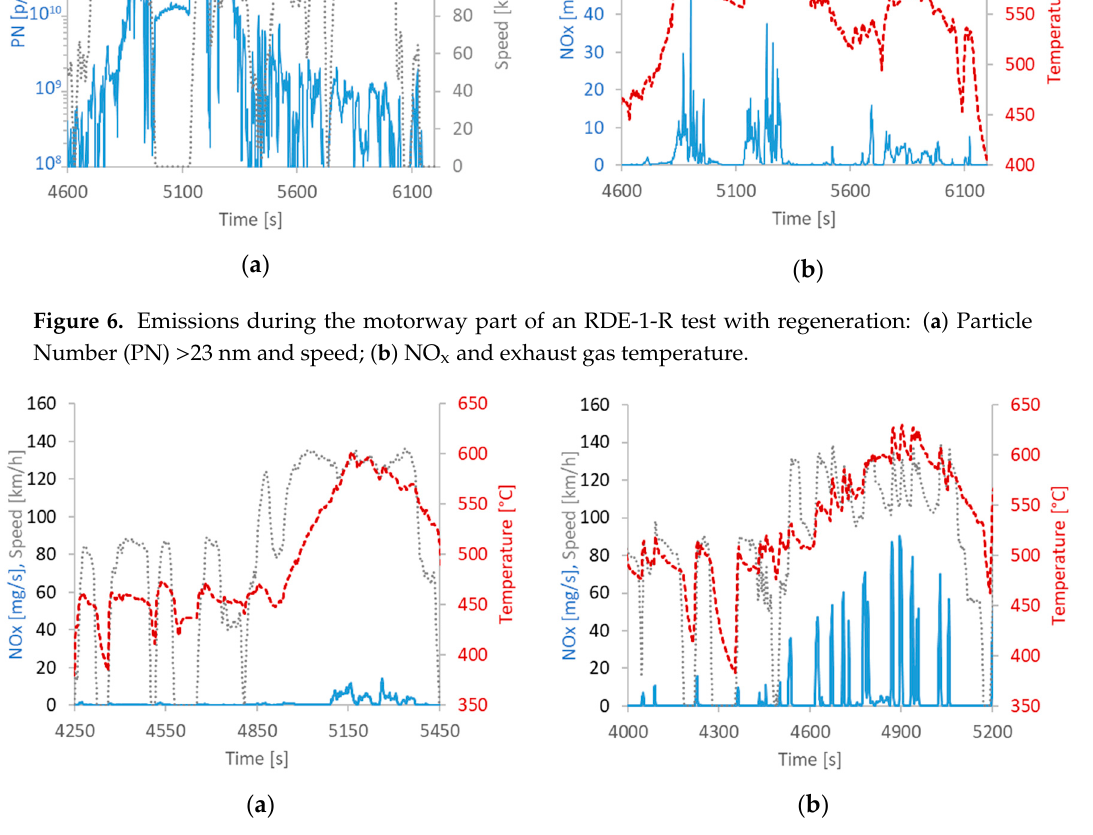
Figure 7. NO x emissions during the rural and motorway part of two RDE tests: ( a ) normal driving RDE-2; ( b ) dynamic driving RDE-2-D.